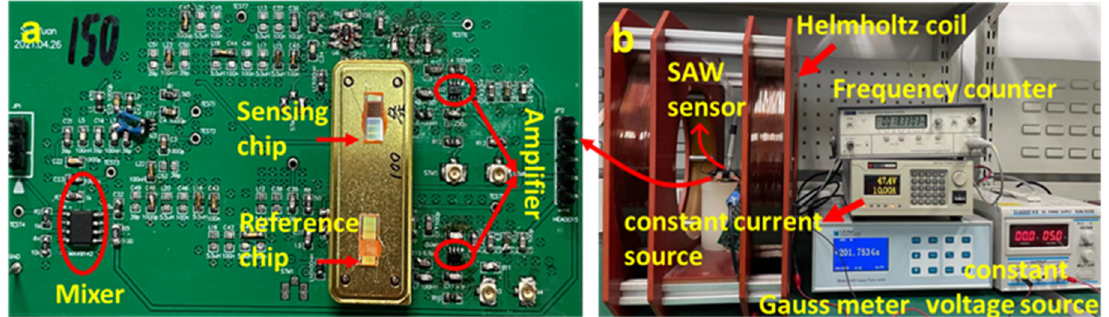
Figure 6. ( a )The view of oscillation circuit board with sensor chip; ( b ) the experimental setup for characterizing the SAW sensors.